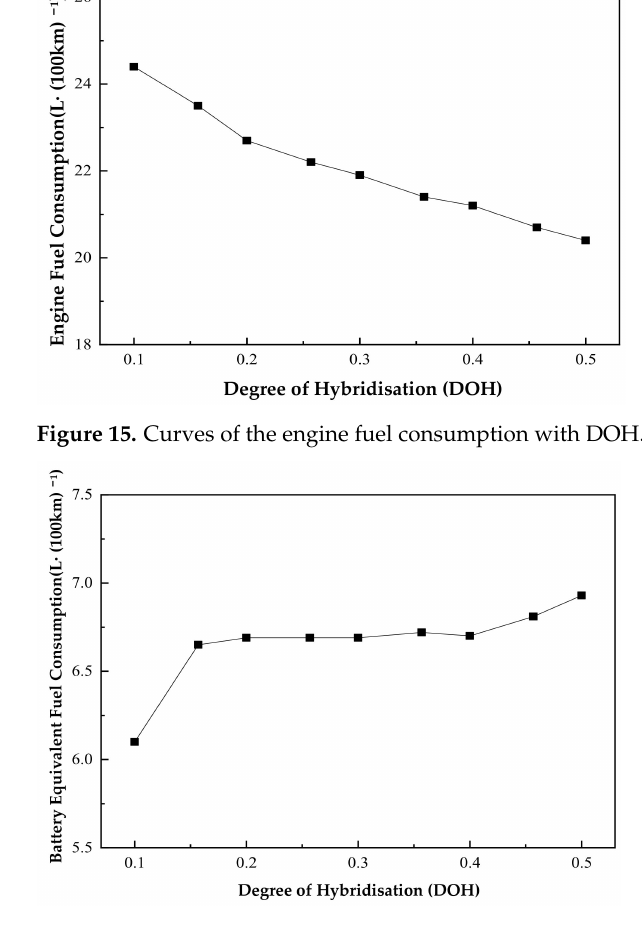
Figure 16. Curves of the battery equivalent fuel consumption with DOH.